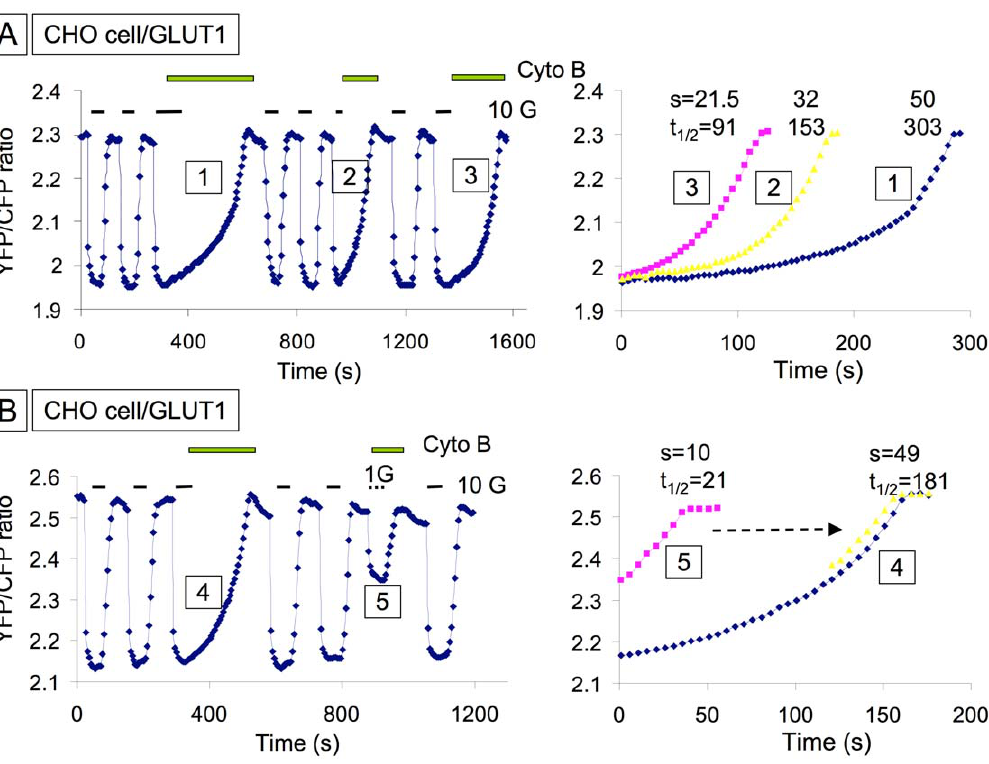
Figure 3. The time of exposure to extracellular glucose controls the rate of intracellular glucose clearance. Panel A illustrates how exposure to 10 mM extracellular glucose for 75 s (1), 30 s (2) and 50 s (3) affects intracellular glucose clearance. In the 3 cases CytoB was applied for 15 s prior to removal of extracellular glucose. The 3 rates are compared in the right hand side panel and show that the final rate of glucose clearance is similar in the 3 cases and that long exposure to extracellular glucose delays the clearance. In B a comparison of data obtained with 10 mM and 1 mM extracellular glucose show that application for up to two minutes of 1 mM glucose had no effect on the rate of intracellular glucose clearance, demonstrating that intracellular glucose must reach a threshold to induce this effect. The right hand side panel shows again that the final rate of glucose clearance measured in the presence of 10 mM glucose is similar to the maximum rate measure with 1 mM and the effect of high glucose is thus to delay